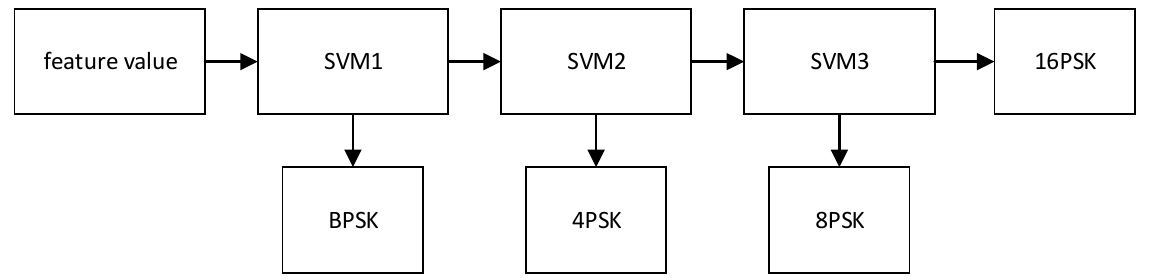
Figure 2. The block diagram of multi-classifier system using SVM.